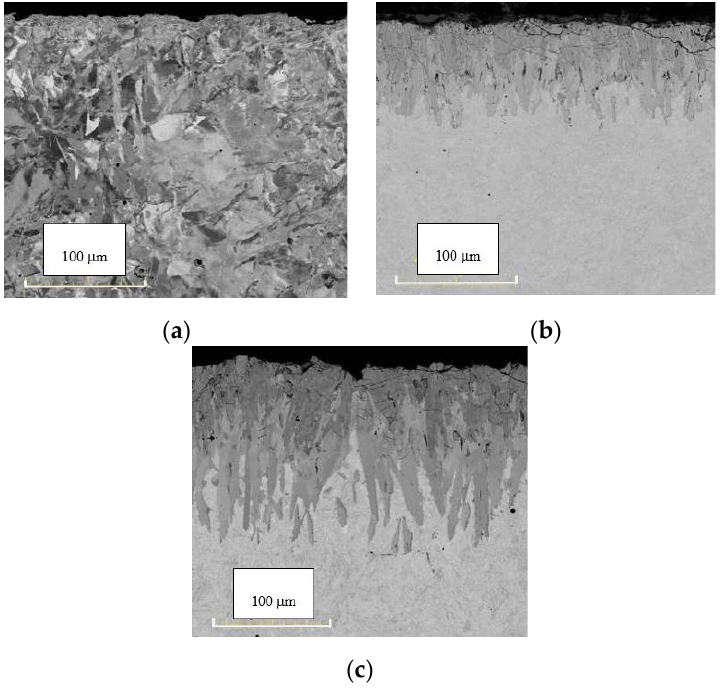
Figure 2. Cross-section metallographic specimens of steel 20GL without modification ( a ), steel 20GL with boriding of type I ( b ), steel 20GL with boriding of type II ( c